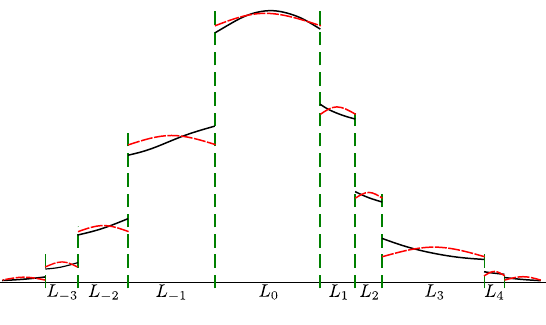
Figure 4. Schematic comparison of the original PDF (black lines) and the base mode approximation (red lines) with gradients exaggerated; for small κ the functions are close to a step function with jumps at the barriers (green lines). The approximation has the shape A k ( t ) cos ( √ 2 κ/ L k x ) inside each domain, centred for the middle. The cosines are then approximated by ones, so the PDF is given by the amplitudes A k ( t ) . The random walk approximation is equivalent to stating that A k evolve according to the master equation d